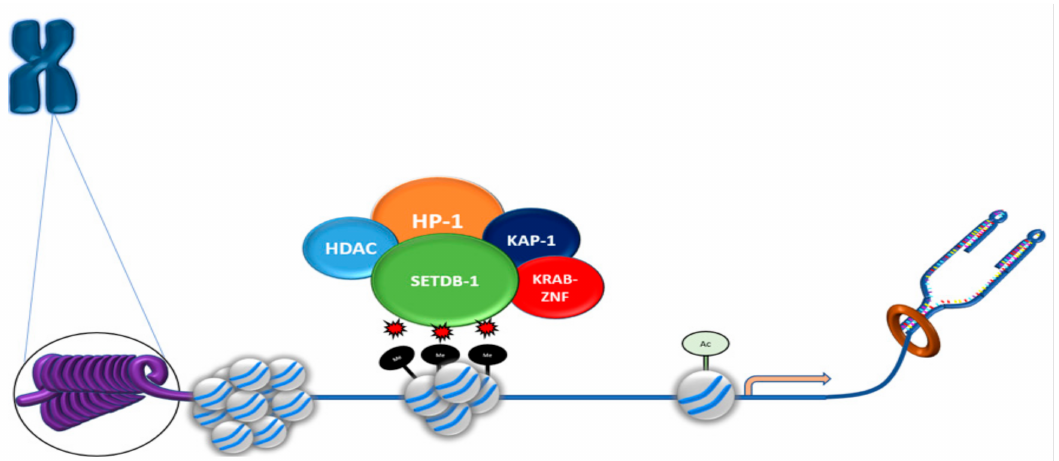
Figure 3. SETDB1 interacts with transcriptional regulators to induce heterochromatin formation. SETDB1 tri-methylation of histone tails is a multifactorial process that requires the orchestrated recruitment and interactions of various chromatin proteins to repress